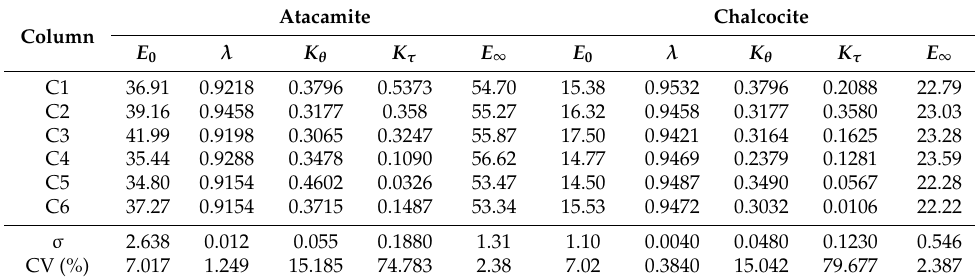
Table 8. Kinetic parameters adjusted from tests